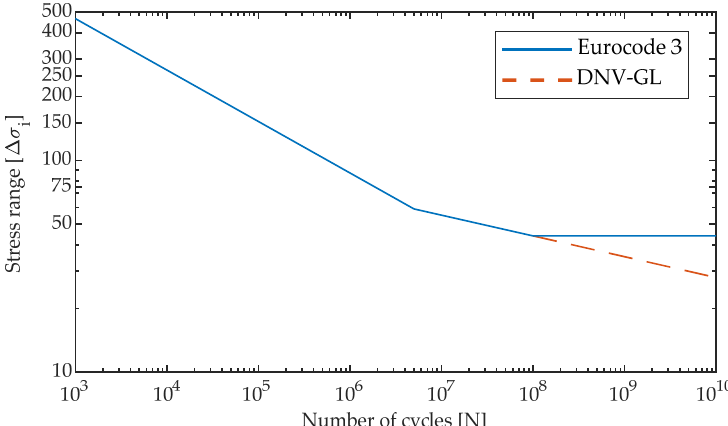
Figure 2. S-N curves defined in GL-2010 and Eurocode 3 (category detail 80 MPa).